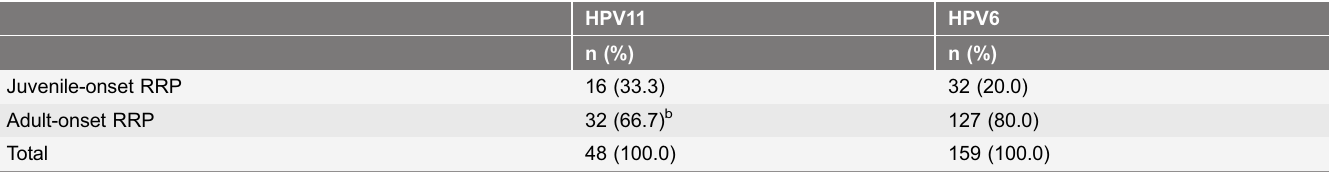
Table 4. Distribution of HPV6 and HPV11 (n 5 207 a